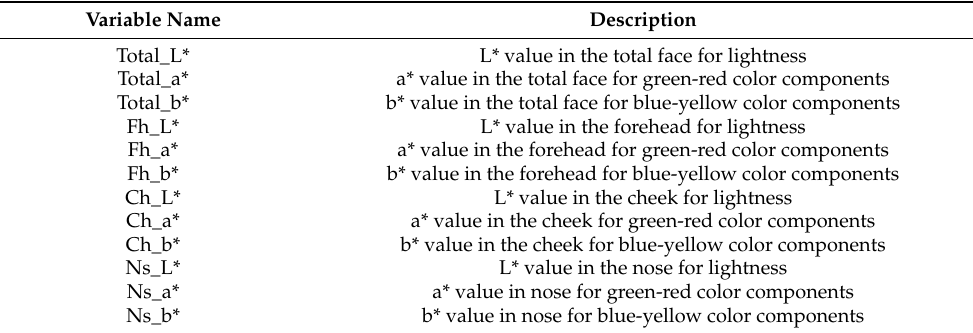
Figure 2. CIELAB color space [24]. L* for lightness, a* and b* for red, green, blue, and yellow of human vision. ’*’ serves as an indication for the Euclidean distance of two color stimuli specified in CIELAB. Table 1. Description of the complexion variables.